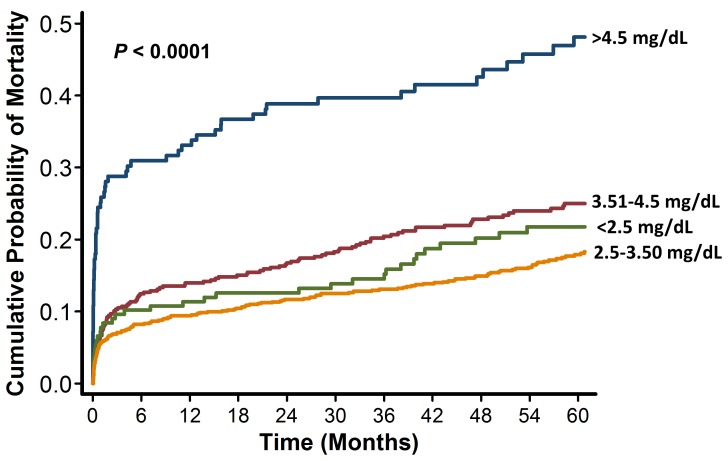
Kaplan-Meier survival plot of mortality.Patients are divided by categories of serum phosphorus. P values are for the overall comparison among the groups using the log rank test.